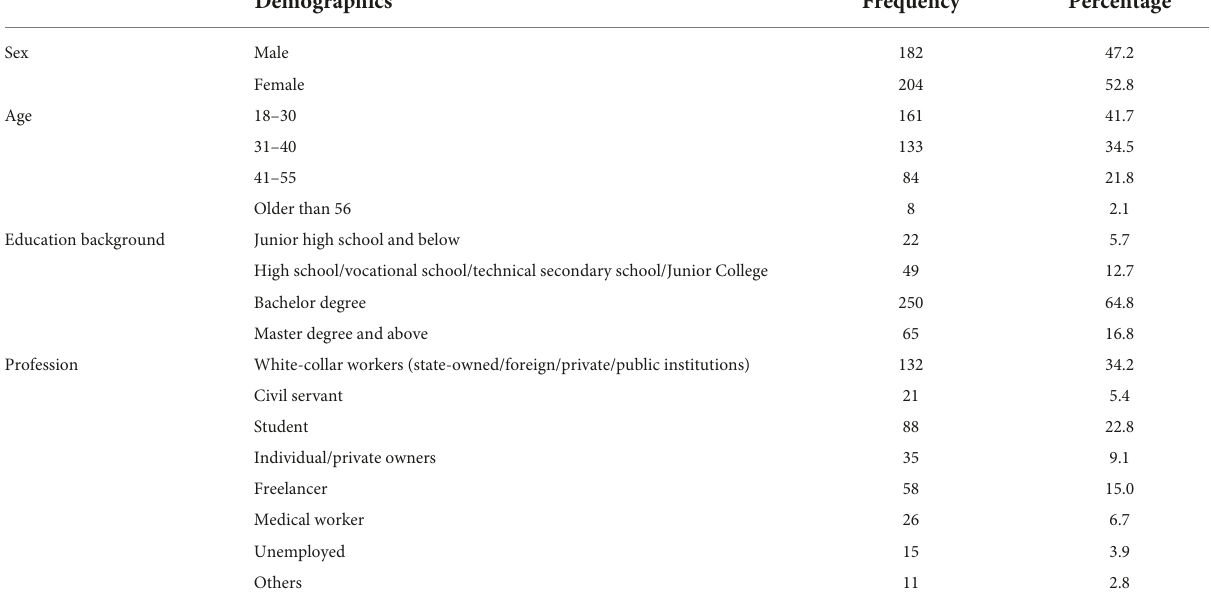
TABLE 3 Demographic information of the sample ( N = 386).